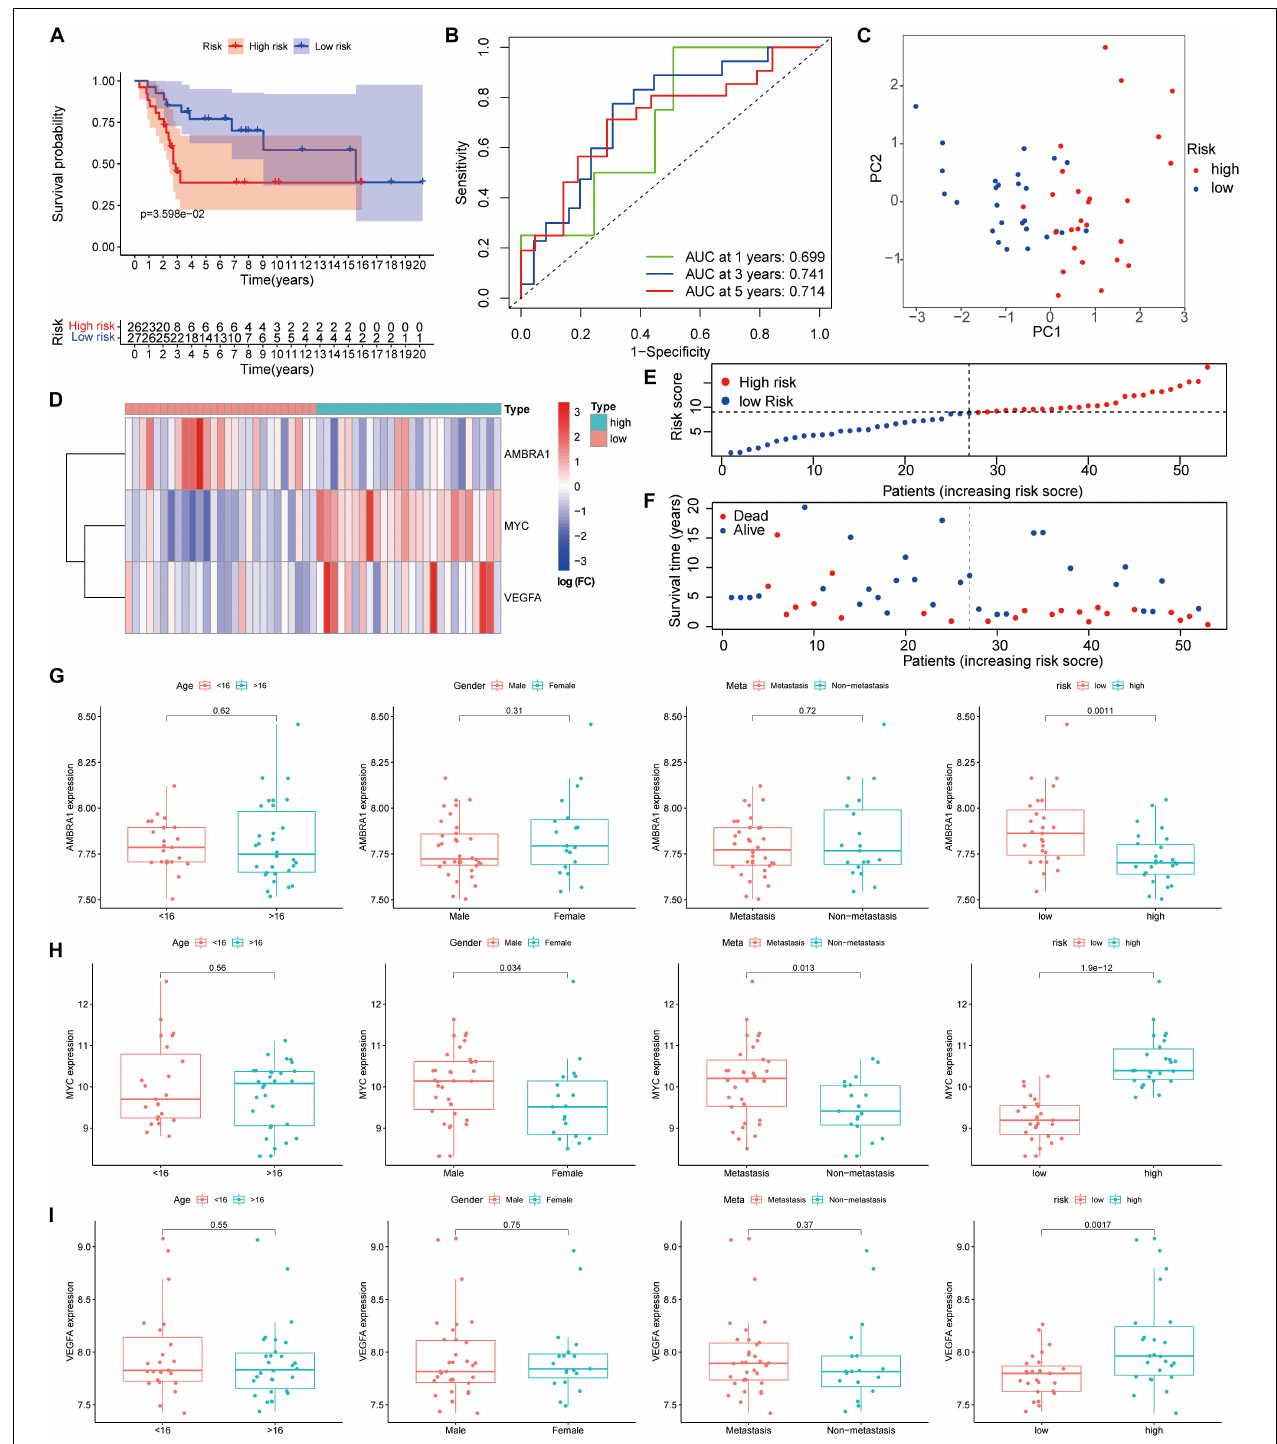
FIGURE 8 | Validation of the autophagy-associated gene signature in the testing group. (A) Kaplan–Meier curves result. (B) The AUC for the prediction of 1, 3, 5-year survival rate. (C) PCA based on the three autophagy-related genes signature. (D) Heatmap of the three genes expressed between the high and low risk group. (E,F) Risk score analysis of the signature. (G–I) The expression of the three key genes, the patients from the GSE21257 dataset were grouped according to age ( < 16 y; ≥ 16 y), gender, metastasis, and riskscore. The X -axis represents the different groups and the Y -axis represents their gene expression levels (normalized signal